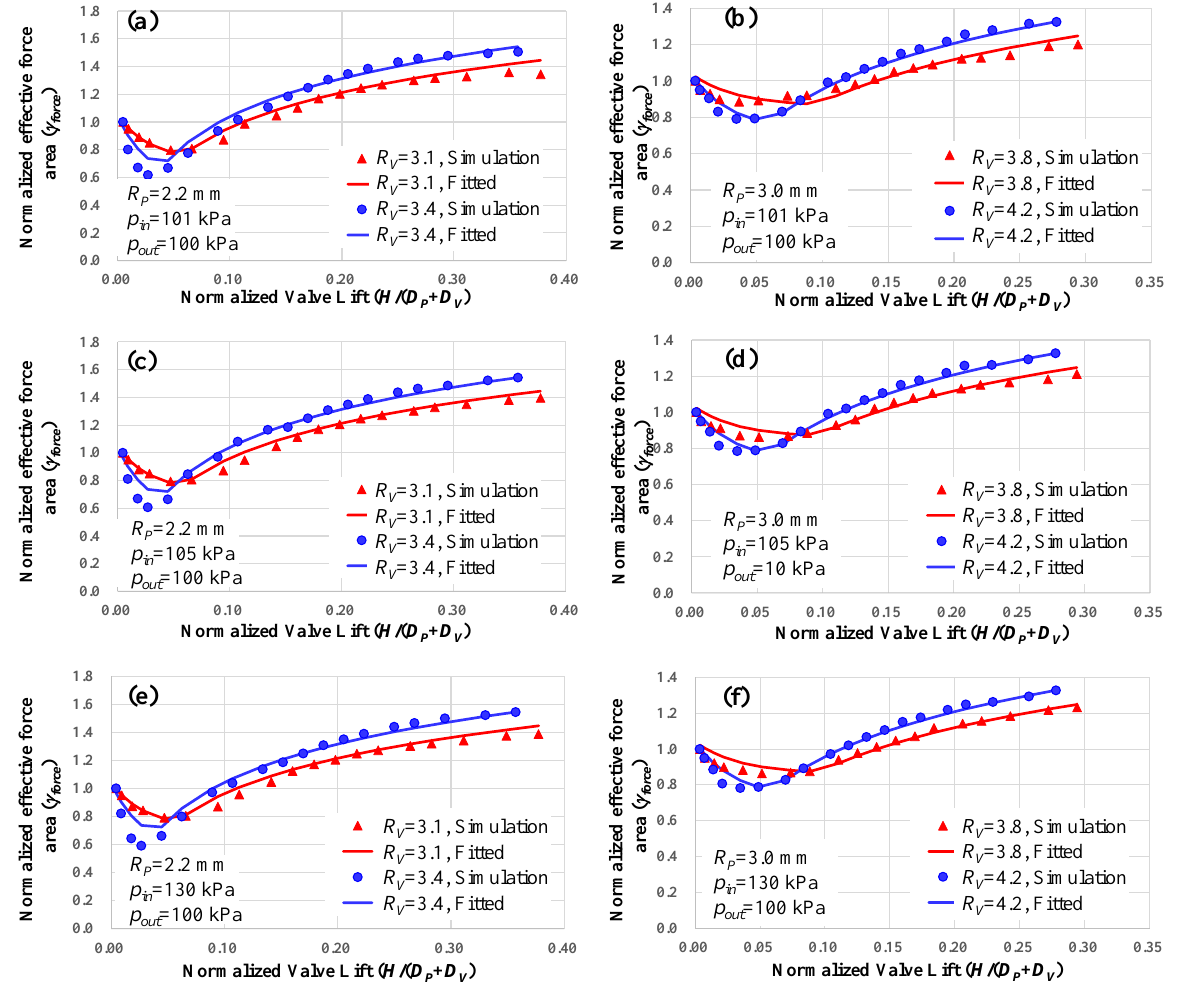
Figure 11. Comparison of normalized effective force area obtained by CFD analysis and fitting: ( a ) R P = 2.2 mm, p in = 101 kPa; ( b ) R P = 3.0 mm, p in = 101 kPa; ( c ) R P = 2.2 mm, p in = 105 kPa; ( d ) R P = 3.0 mm, p in = 105 kPa; ( e ) R P = 2.2 mm, p in = 130 kPa; and ( f ) R P = 3.0 mm, p in = 130 kPa.